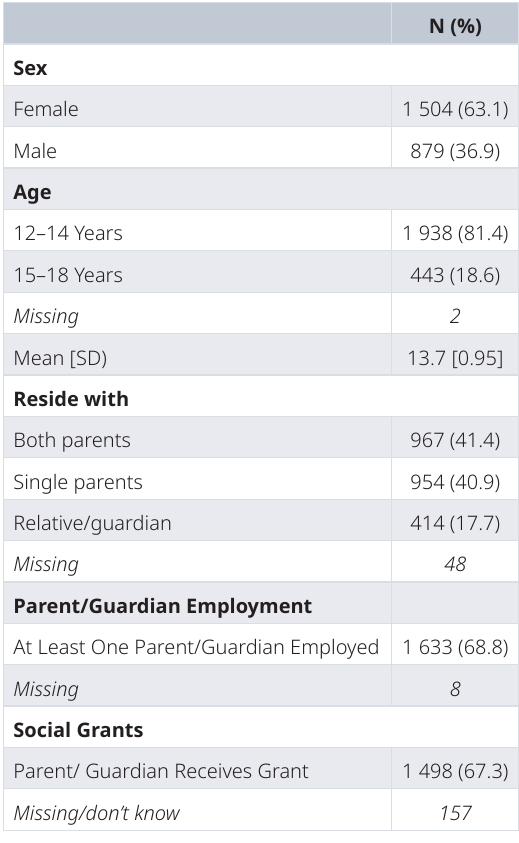
Table 1. Summary of socio-demographic variables of participants (n=2383).